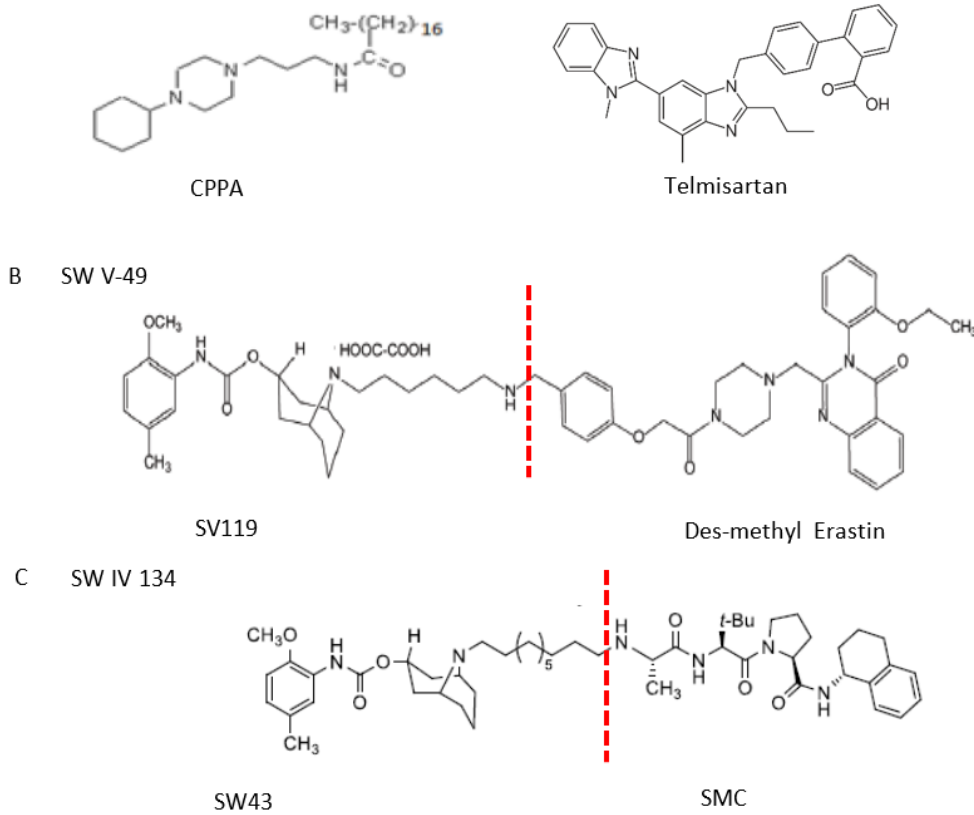
Figure 4. The structures of CPPA-TEL-NLP, SW V-49, and SW IV 134. ( A ) The structure of CPPA and Telmisartan: CPPA-TEL-NLP was prepared by anchoring CPPA to nanostructured lipid particles of Telmisartan. ( B ) The sigma-2 ligand SV119 was chemically conjugated to dm-Erastin, resulting in the sigma-2/dm-Erastin conjugate SW V-49. ( C ) SW IV 134 was constructed by sigma-2 ligand SW43 and small molecule SMAC mimetic compound (SMC). CPPA-TEL-NLP: 3-(4-cyclohexylpiperazine-1-yl) propyl amine (CPPA) anchored nanostructured lipid particles (NLP) of telmisartan (TEL).